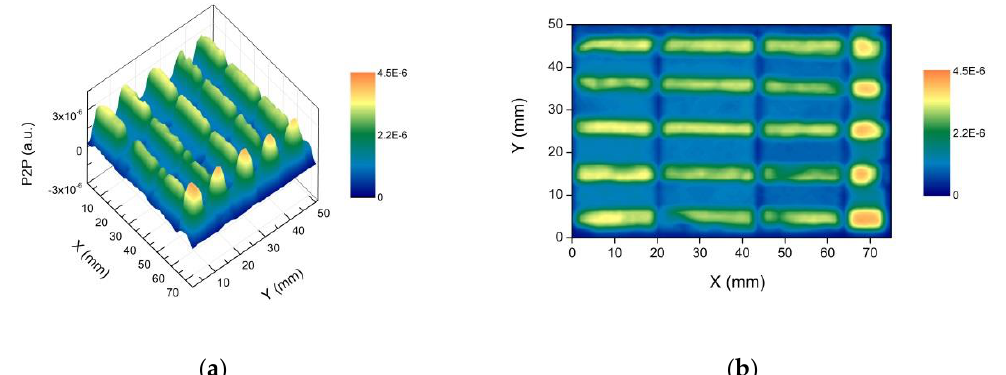
Figure 7. ( a ) THz imaging of the multi-layered sample: on the vertical axis is reported the difference between the maximum and the minimum of each waveform; on the horizontal plane, the measuring point coordinates; ( b ) the projection on the XY plane.